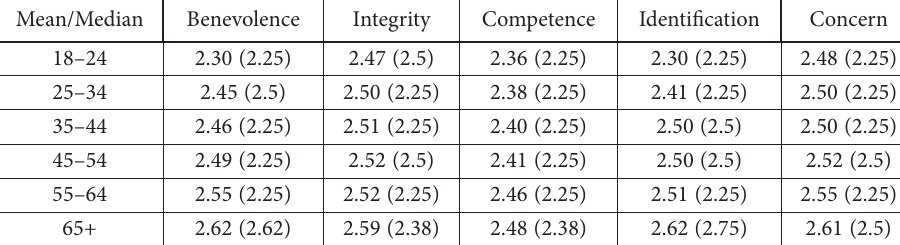
Table 4. Mean (median) trust dimensions scores: Comparisons by age (source: own research) Mean/Median Benevolence Integrity Competence Identification Concern 18–24 25–34